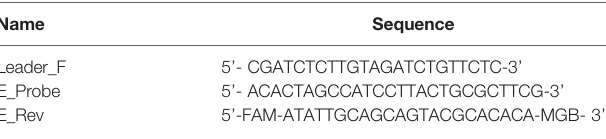
TABLE 1 | E sgmRNA primers.